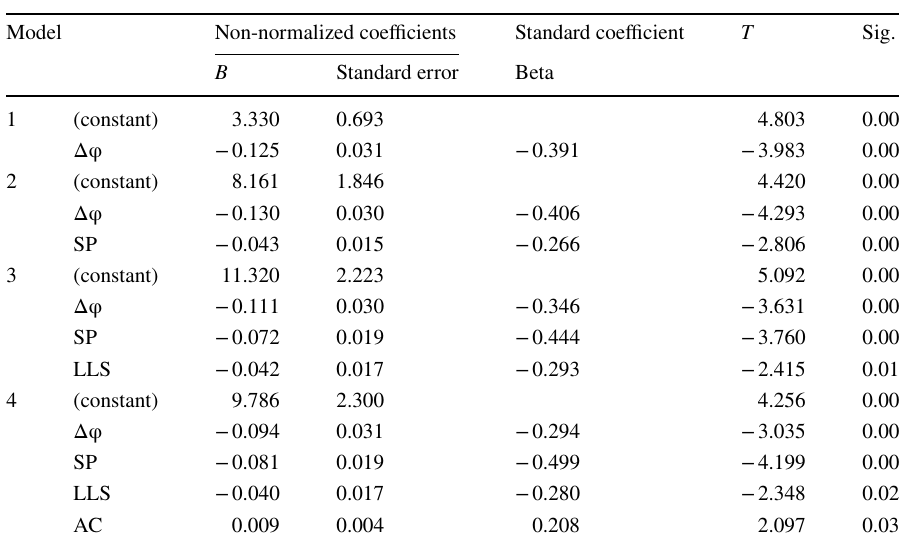
Table 4 The statistic result of forward